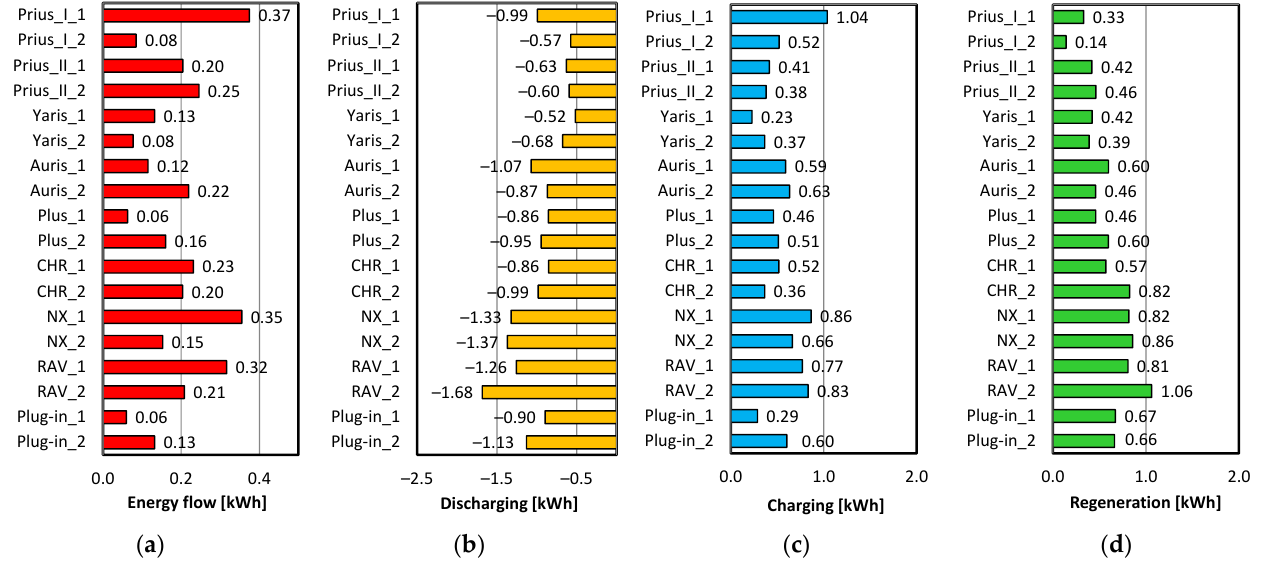
Figure 7. Analysis of energy flow in hybrid drives under urban driving conditions: ( a ) total energy flow (sum of discharging, charging and charging during regenerative braking); ( b ) discharge; ( c ) charging; ( d ) charging during regenerative braking.